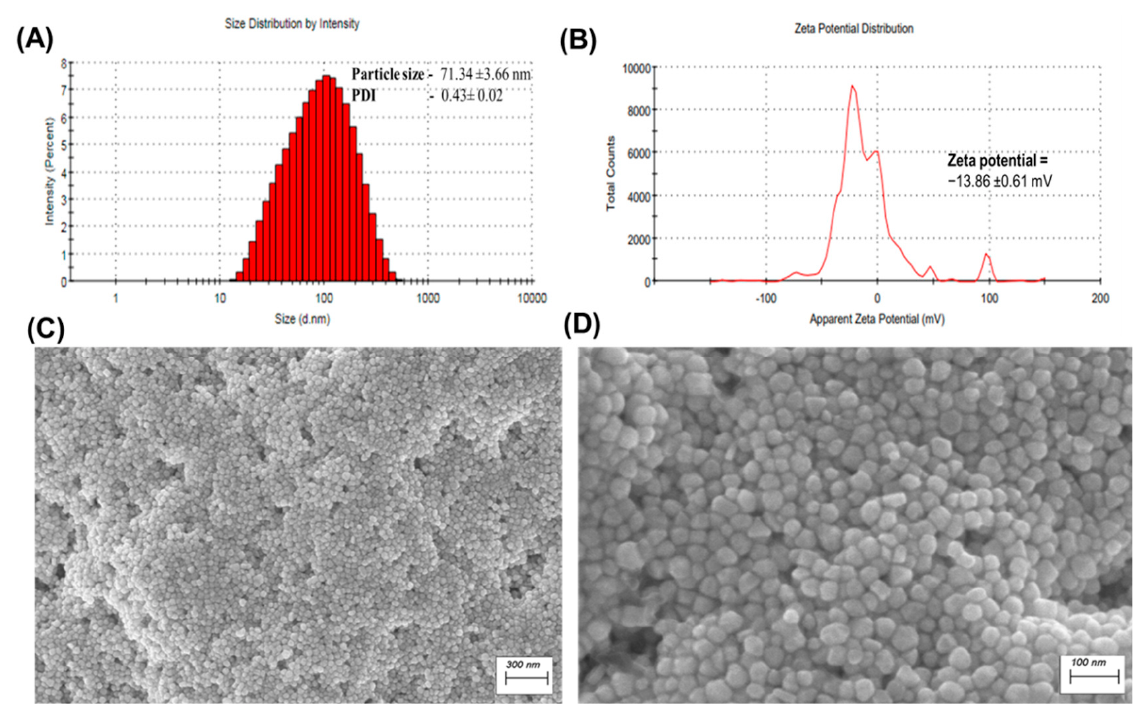
Figure 1. Characterization of T GNC-DOX. ( A ) Particle size histogram of prepared T GNC-DOX. ( B ) Zeta potential graph. ( C ) FE-SEM image of T GNC-DOX (scale: 300 nm). ( D ) Magnified FE-SEM image of T GNC-DOX (scale: 100 nm) (Represented values are n = 3).